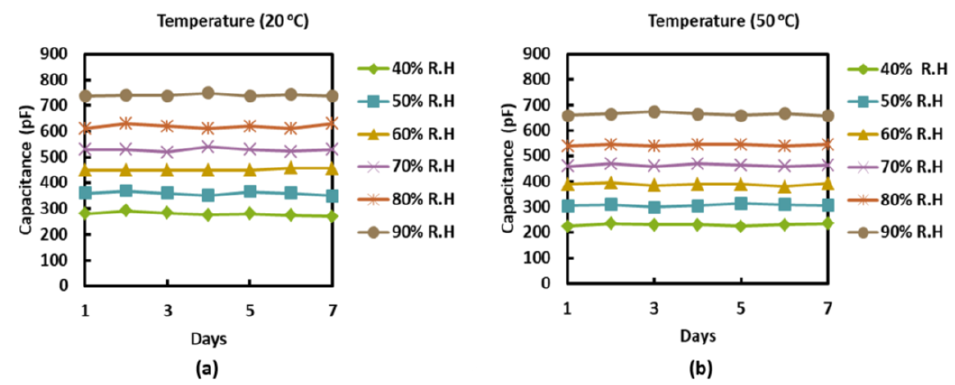
Figure 7. Capacitance of sensor measured at different values of %RH at ( a ) 20 °C and ( b ) 50 °C.